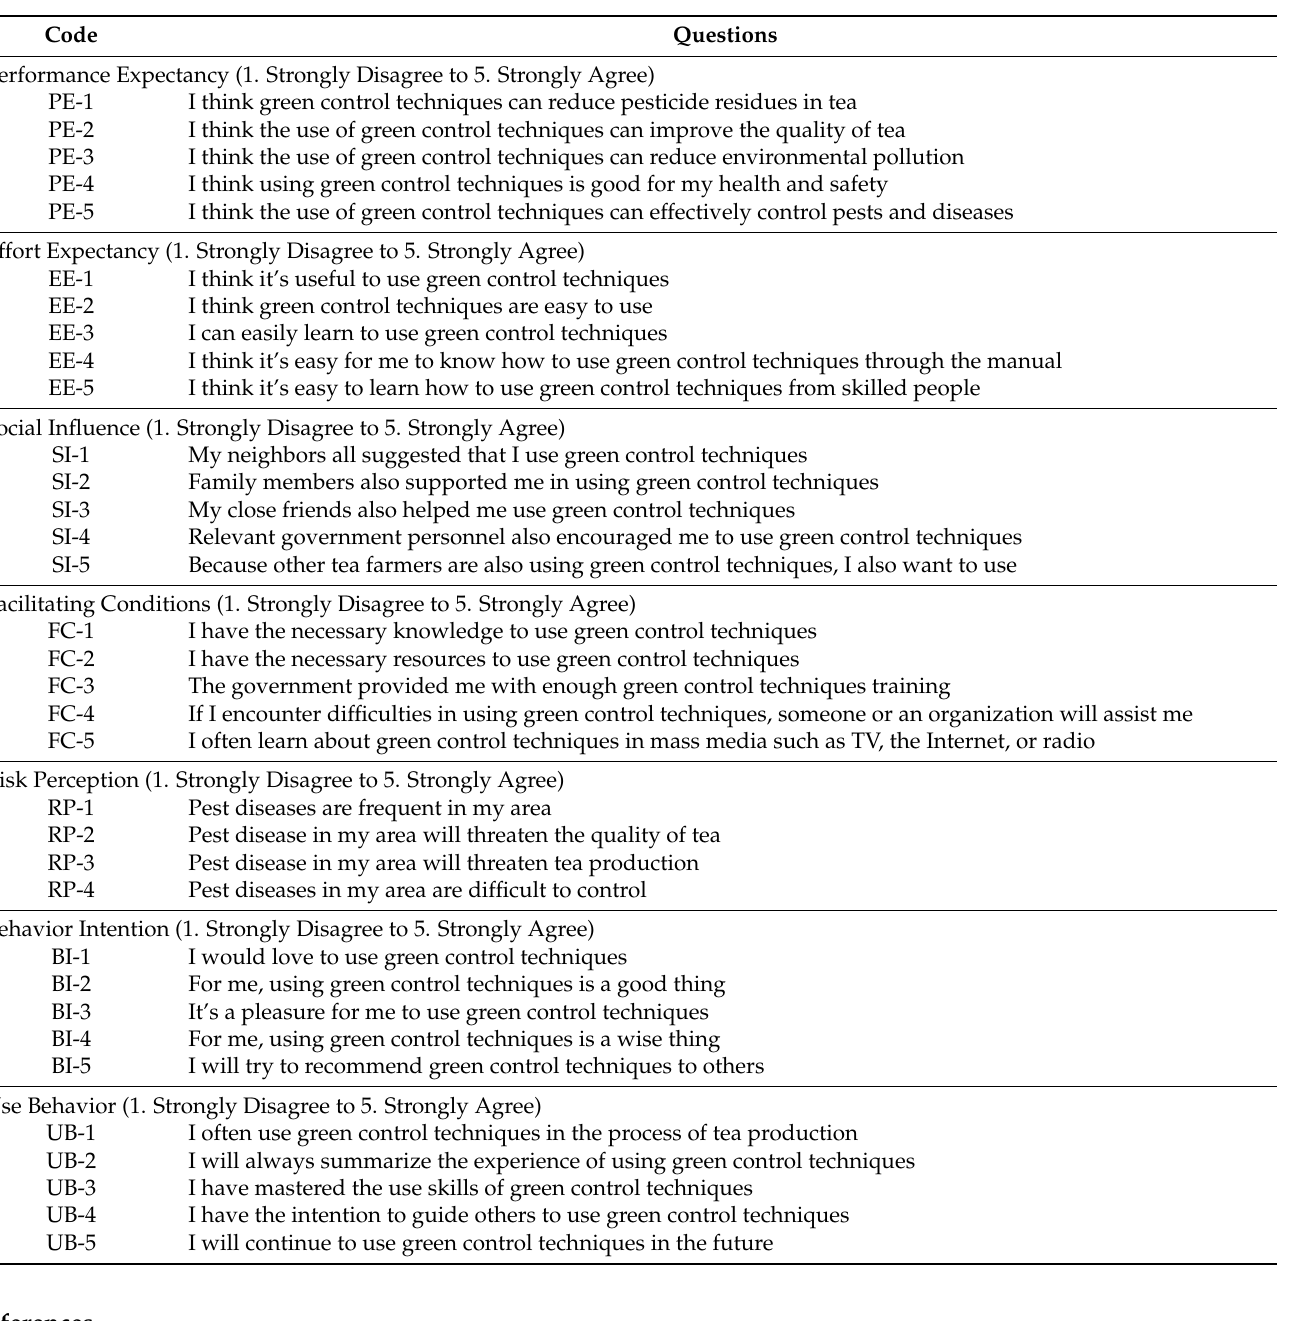
Table A1. Survey